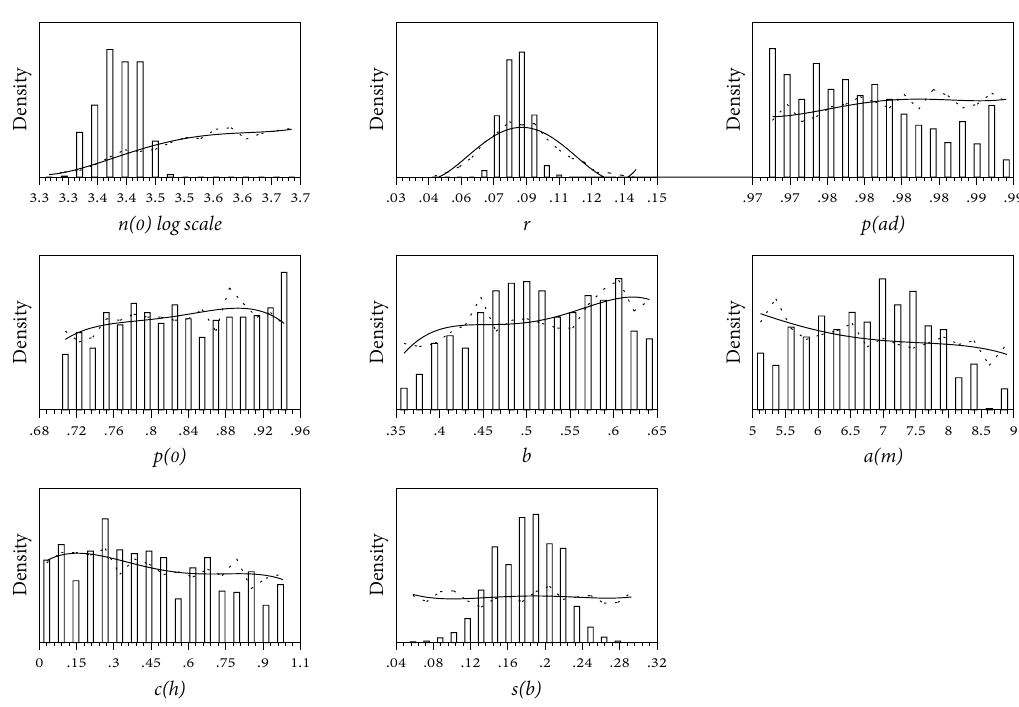
Fig. 3. Realised prior (dashed curve; solid curve fitted polynomial) and posterior (bars) parameter distributions for exponential growth in Baffin-Bay walruses (model eB). For parameter symbols see Table